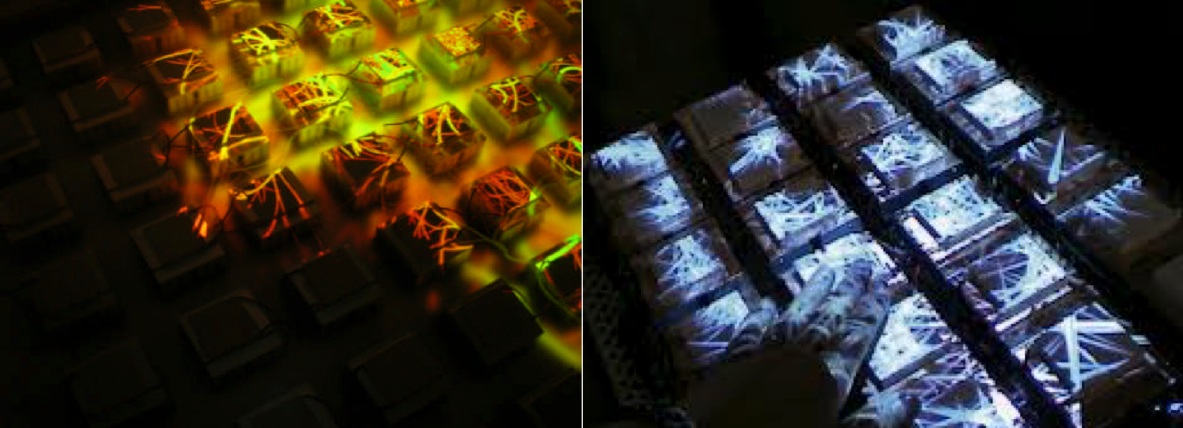
Figure 3 | Kumiko Kushiyama, Thermoesthesia, 2006, Courtesy of the